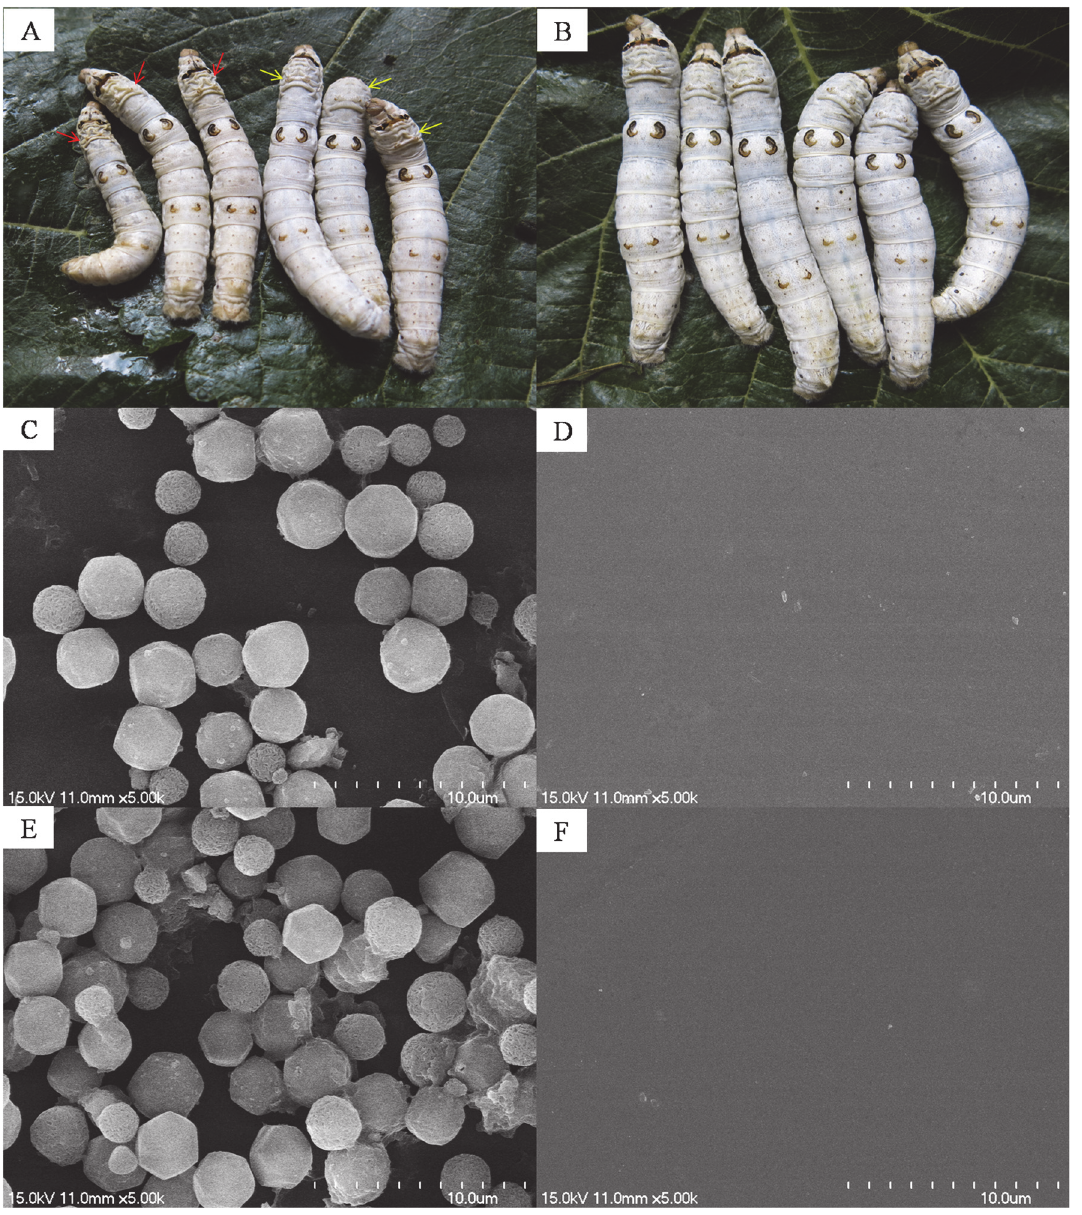
Fig 2. Detection of BmNPV in infected larvae and hemolymph. A, Silkworms in the control group at 120 h; red arrows point to the silkworms with apparent symptoms of BmNPV disease, and yellow arrows point to the silkworms without apparent symptoms of BmNPV disease. B, Silkworms in the experimental group at 120 h. C and E, and D and F represent SEM results of the control group and the experimental group at 120 and 144 h in the hemolymph of BmNPV,